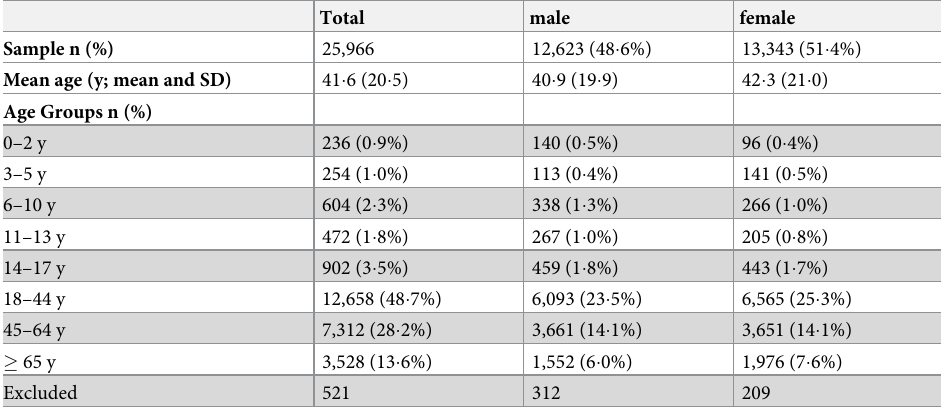
Table 1. Study population.